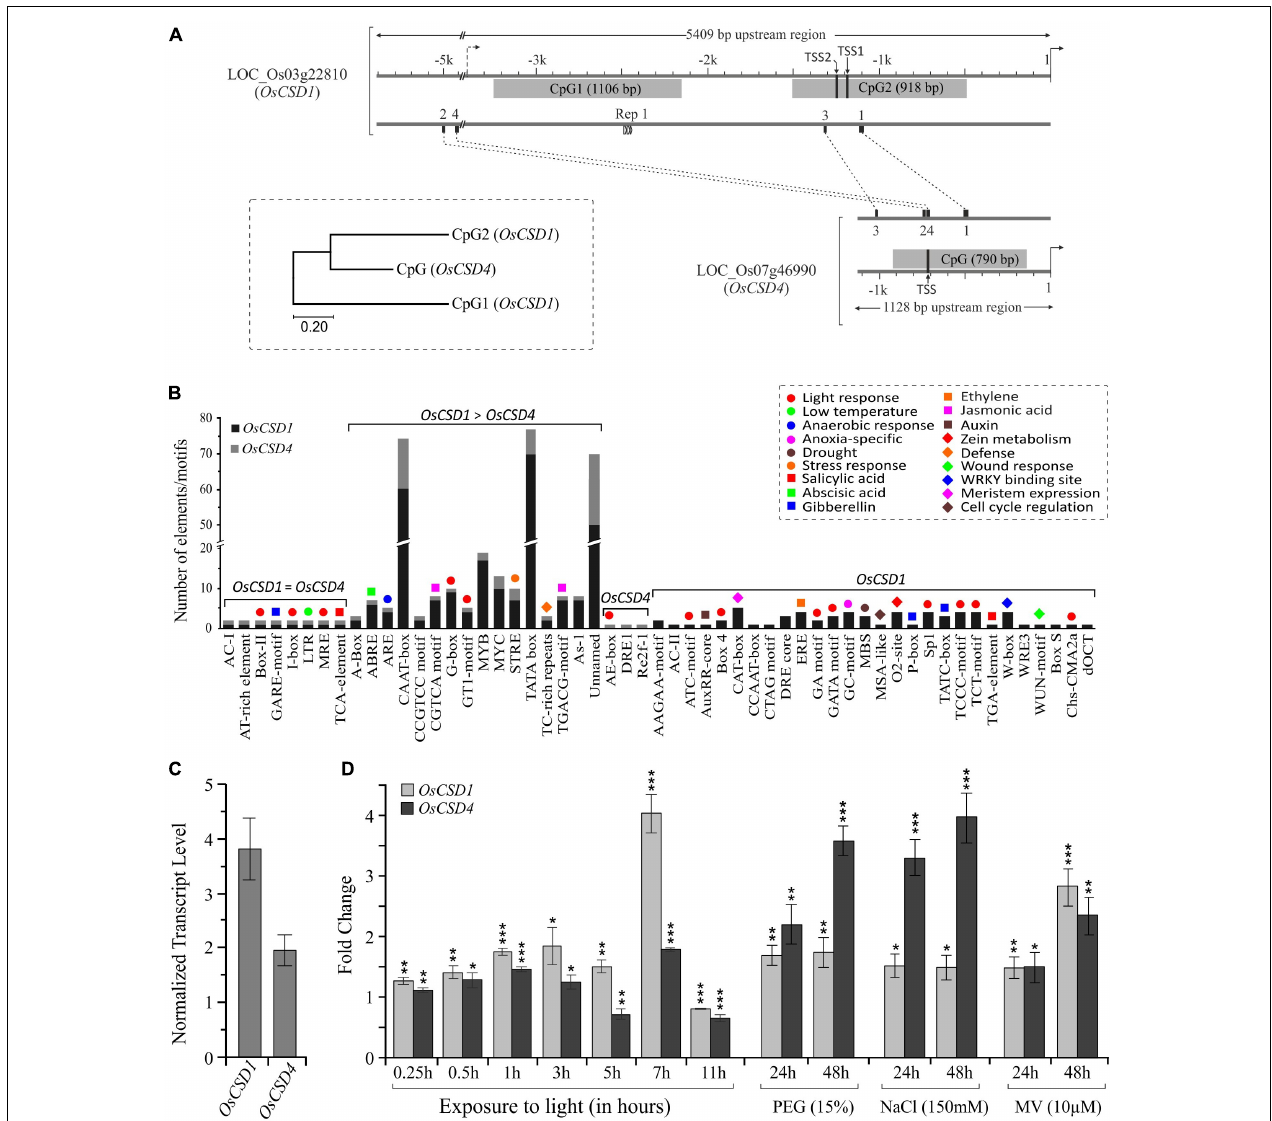
FIGURE 3 | Promoter region differences and expression pattern of OsCSD1 and OsCSD4 genes. (A) The length and location of CpG islands (gray boxes), positions of conserved motifs (1, 2, 3, 4), repetitive motif (Rep1), and two potential TSS sites in OsCSD1 -CpG2 and one in OsCSD4- CPG are indicated. The scale on the top indicates the length of the upstream region. The dendrogram shows the divergence between the OsCSD1 and OsCSD4 CpG islands. (B) The bar plot shows the abundance of different categories of cis -elements (indicated by color-coded symbols) in the promoter of two OsCSD s. Single copy, differentially abundant, and gene-specific cis -elements are grouped separately. (C) Reverse transcription-quantitative PCR (RT-qPCR)-based analysis of relative abundance of OsCSD1 and OsCSD4 transcripts in rice shoot tissue. (D) Expression pattern of OsCSD1 and OsCSD4 transcripts in light (0–11 h) and in response to polyethylene glycol (PEG, 15%), sodium chloride (NaCl, 150 mM), and methyl viologen (MV, 10 µ M) at 24 and 48 h time points after stress treatment. The transcript levels were estimated using actin as a reference gene. The experiment was repeated three times and data are represented as mean value ± SD. Statistical significance is indicated by *( p < 0.05), **( p < 0.01), ***( p <